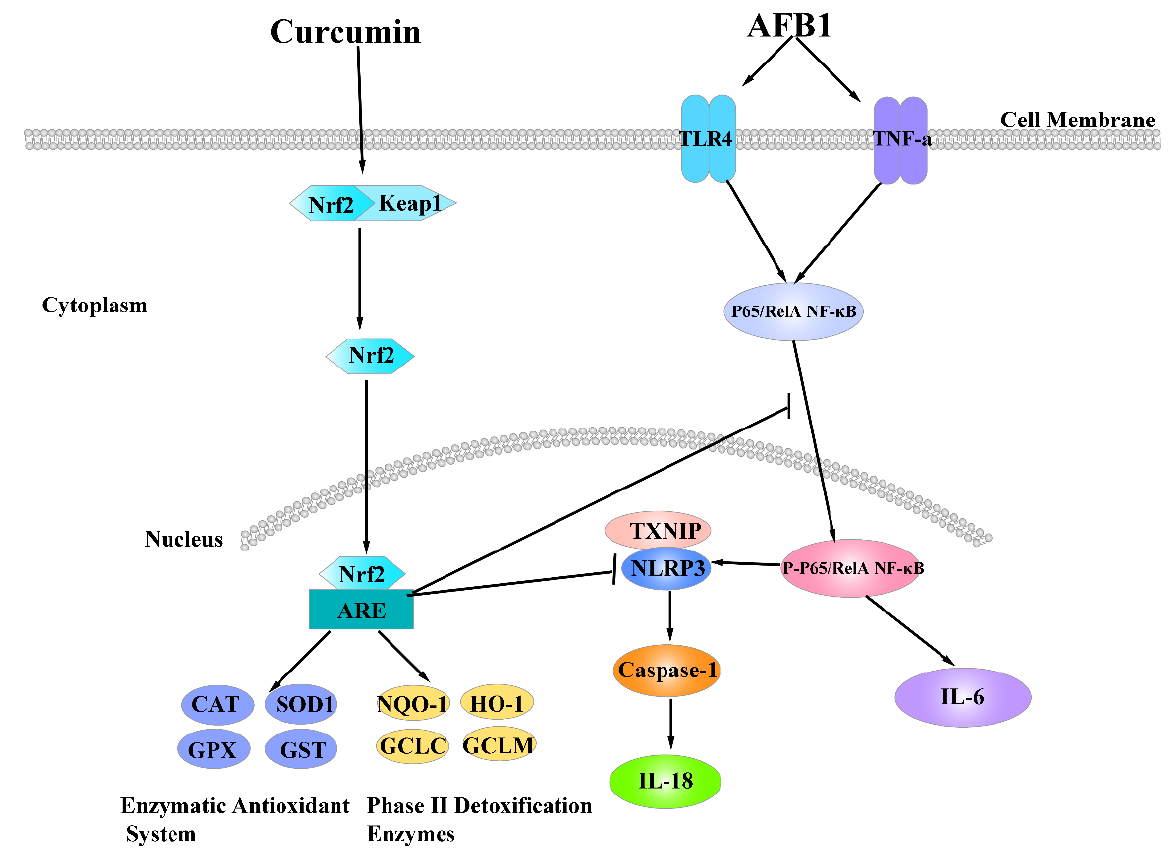
Figure 6. The antioxidant damage mechanism of dietary curcumin through Nrf2-ARE signaling pathway to elevate the expression of its downstream genes, including the antioxidant enzymatic system (CAT, SOD1, GPX and GST) and phase II detoxification enzymes (NQO-1, HO-1, GCLC and GCLM), as well as anti-inflammatory mechanism via inhibiting expression of genes related to NF- κ B signaling pathway.